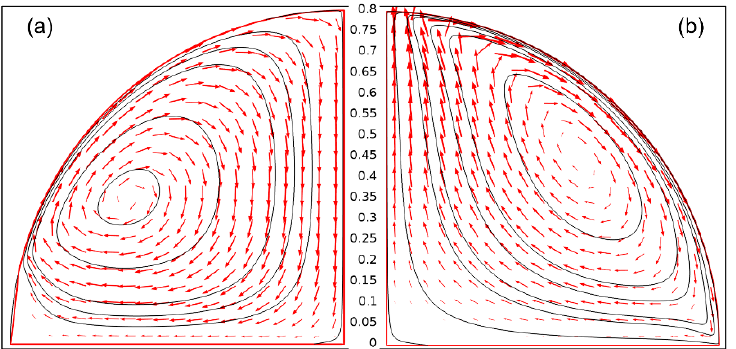
Figure 10. Streamlines and flow direction inside water droplet for two configurations. (t = 1 s, V 0 = 1 mm 3 , θ = 90 ◦ ) ( a ): BH (T = 50 ◦ C) ( b ): TH ( Φ = 40 mW).